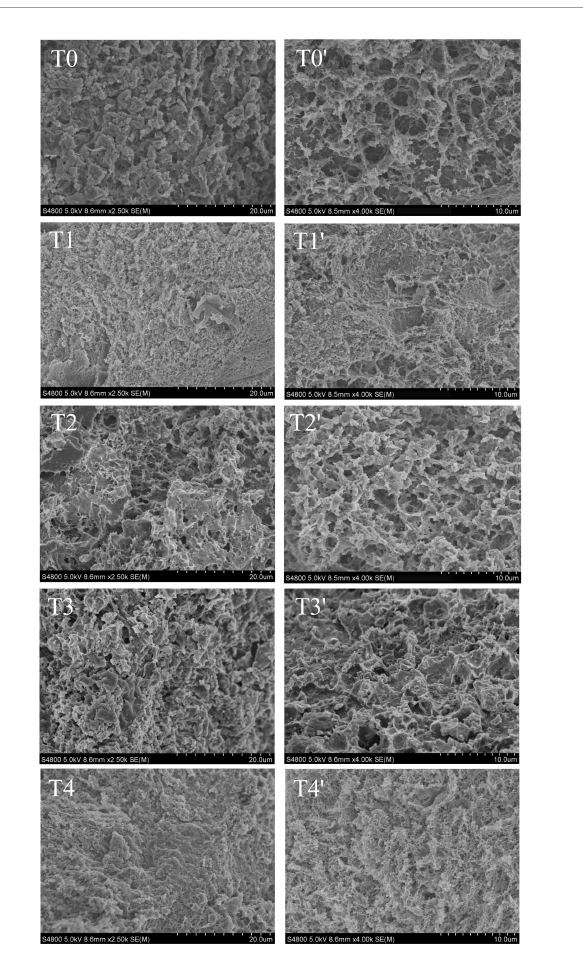
FIGURE6 Effect of composite dietary fiber on the microstructure of MP gel. T0: control group; T1: 6.06% chaff dietary fiber; T2: 6.06% soybean hull dietary fiber; T3: 6.06% inulin; T4: 1.40% chaff dietary fiber + 1.42% soybean hull dietary fiber + 3.24% inulin. T0–T4: the sample